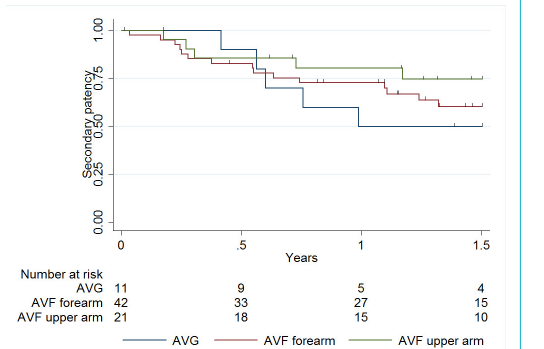
Figure 5: Secondary patency of primary vascular access: median secondary patency 458 days (interquartile range 223–767). AVF = arteriovenous fistula; AVG = arteriovenous graft